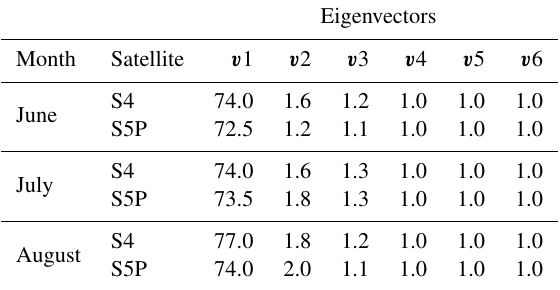
Table 1. Monthly observation standard deviation, in ln ( vmr ppm ) , for S4 and S5P. The observation error covariance matrix ( R ) used in our assimilation system for summer 2003 is a diagonal matrix in which the diagonal elements correspond to the variance (the square of the values present in this